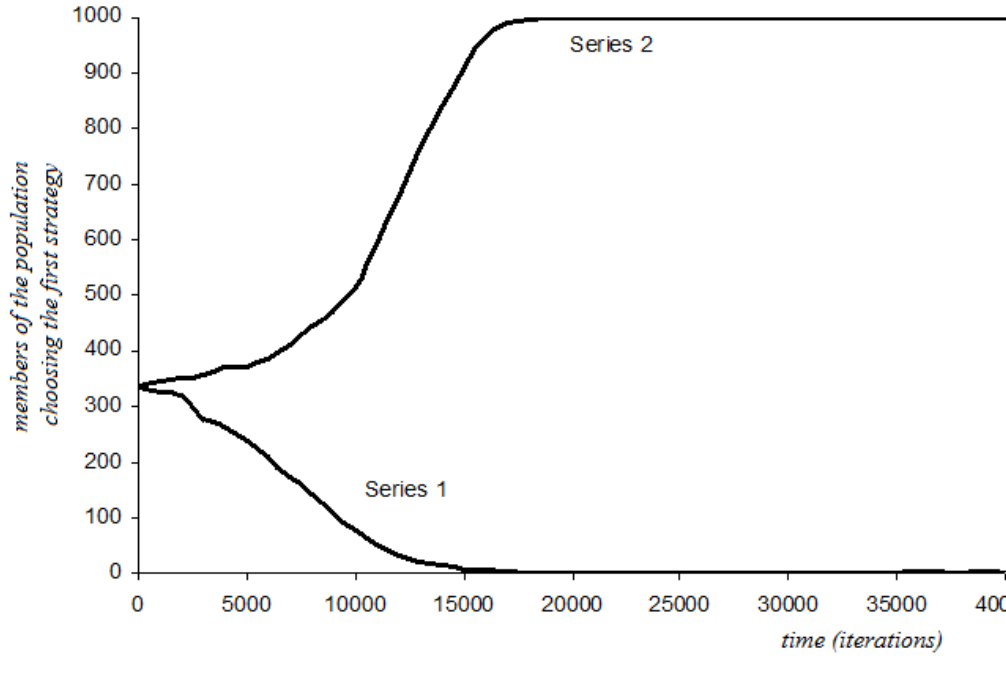
Figure 6. ‘ Hi-Lo ’ with p = 0.35. Series 1: a = 0.1, b = 1. Series 2: a = 0.15, b = 0